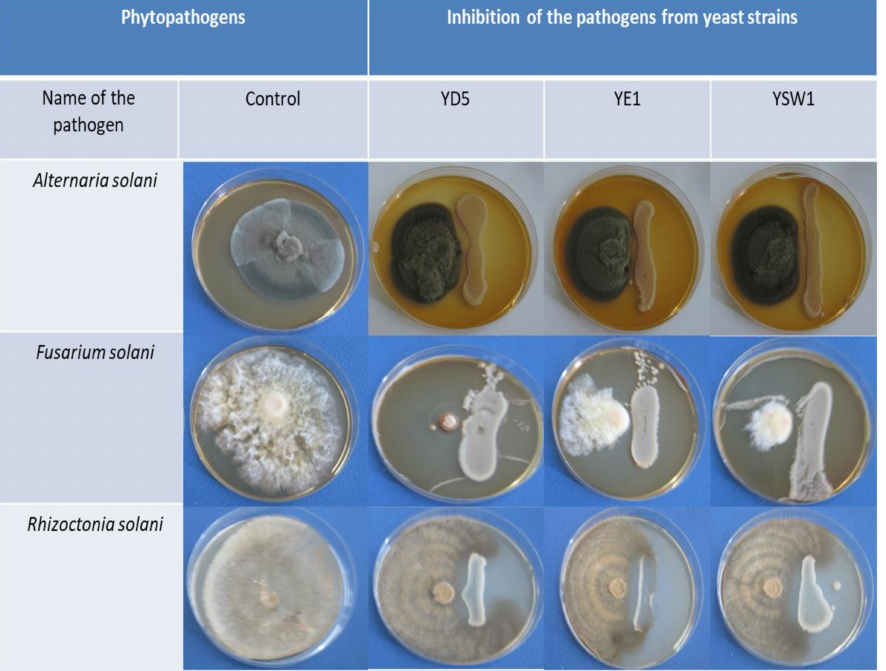
Figure 2. Antimicrobial activities of isolated yeast strains against three phytopathogens: Alternaria solani pathovar. tobacco, Rhizoctonia solani, and Fusarium solani pathovar. phaseoli